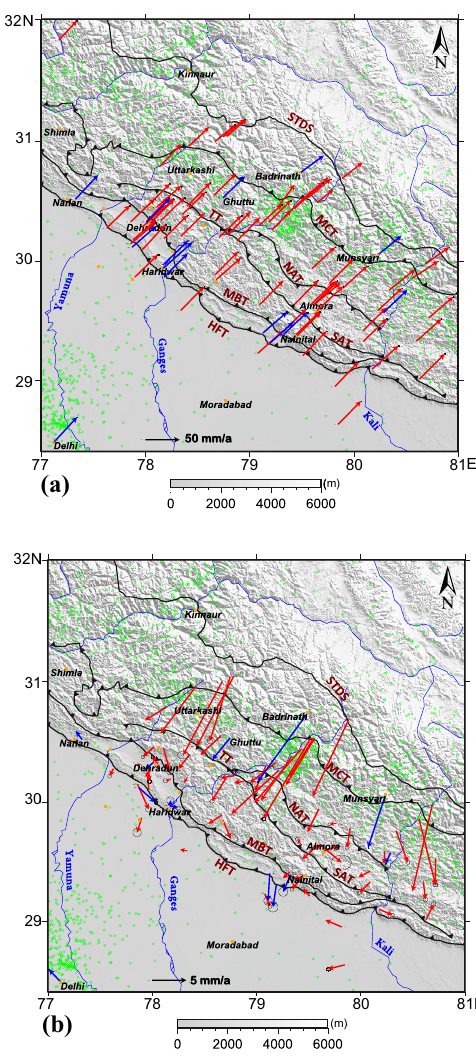
Figure 2. (a) Figure shows the velocities of the GPS stations in the Garhwal–Kumaun region in ITRF2008. The blue arrows represent the velocities of WIHG GPS stations whereas the red arrows represent the velocities from published works. Seismicity of the region is marked as green circles. The figure was created by Generic Mapping Tool (GMT) open source software version 5.4.5 (https:// www. gener ic- mappi ng- tools. org/). ( b ) Figure shows the velocities of the GPS stations in the Garhwal–Kumaun region in the Indian reference frame 32 . The blue arrows represent the velocities of WIHG GPS stations whereas the red arrows represent the velocities from published works. Seismicity of the region is marked as green circles. The figure was created by Generic Mapping Tool (GMT) open source software version 5.4.5 (https:// www. gener ic- mappi ng- tools.